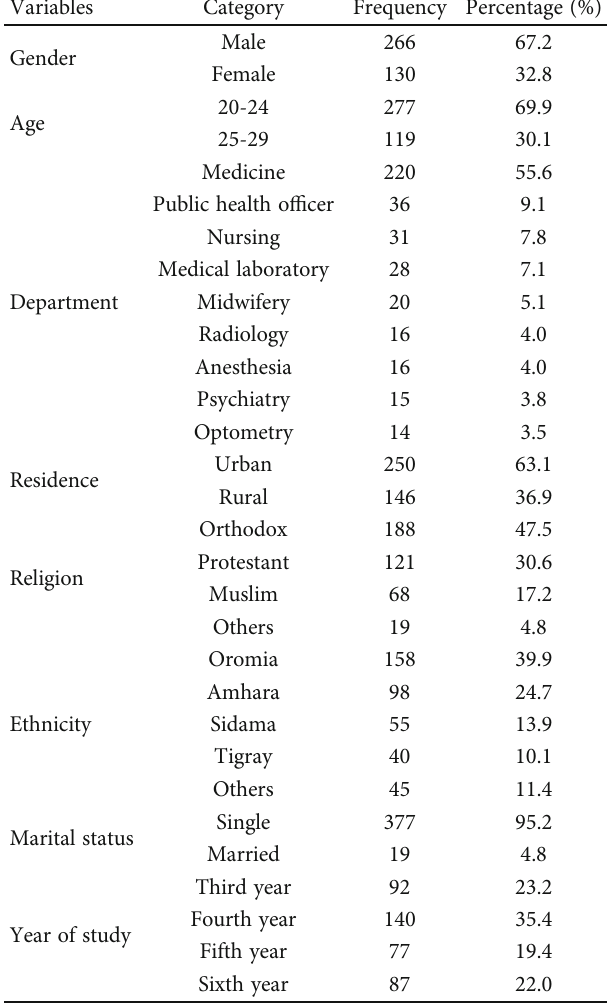
Table 1: Frequency distribution of sociodemographic characteristics of the study participants at HUCMHS, Hawassa, Ethiopia, 2021 ( n = 396